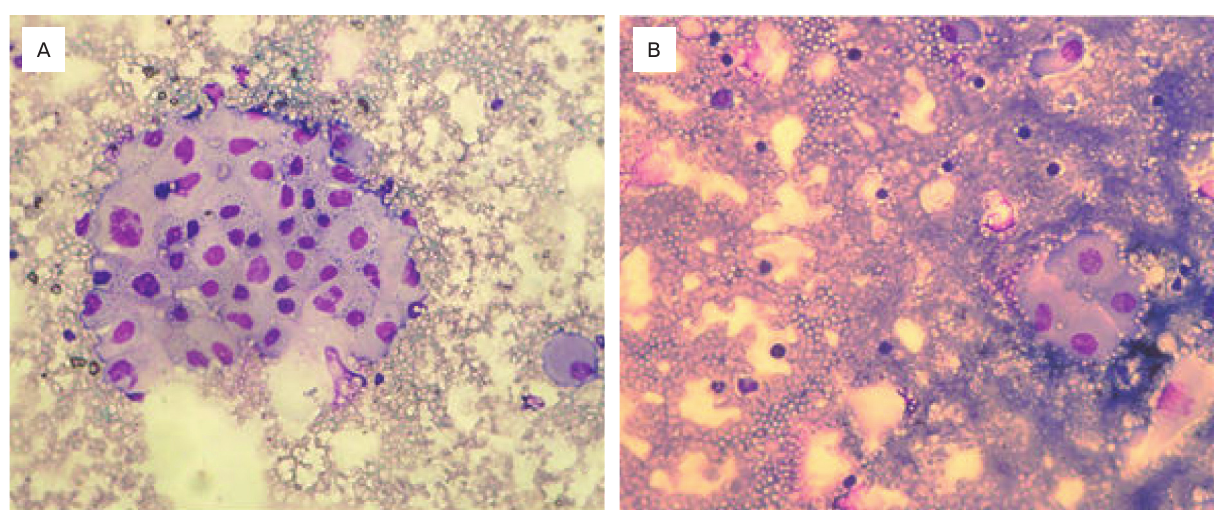
Figura 4. Fotomicrografi a do lavado vesical de bovinos. (A) Predominância de células uroteliais; (B) células infl amatórias e células uroteliais. Coloração de Giemsa.